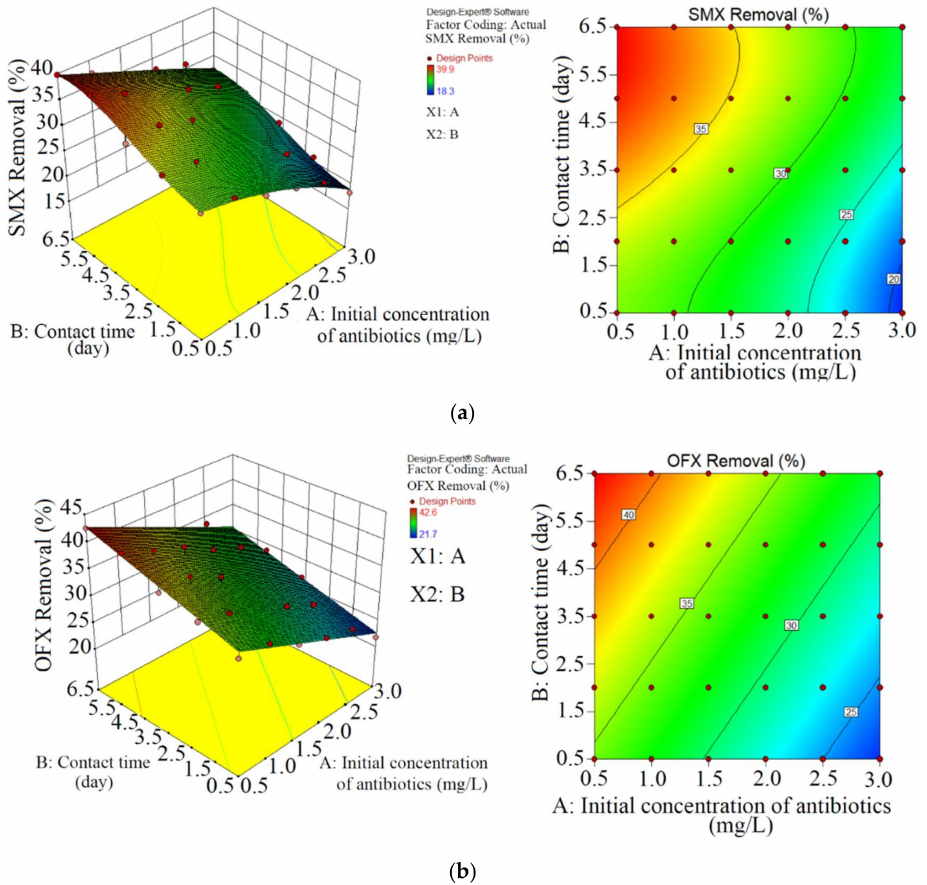
Figure 2. The 3D plots for the removal of SMX ( a ) and OFX ( b ) with diatom. Based on RSM optimization, optimum abatement of SMX and OFX were 39.8% (0.19 mg L − 1 ) and 42.5% (0.21 mg L − 1 ) at the initial concentration (0.5 mg L − 1 ) and